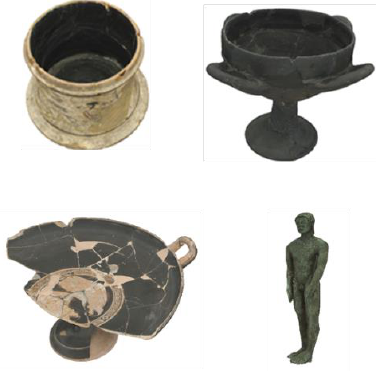
Figure 3. Some of the artefacts digitized at National Archaeological Museum of Marche